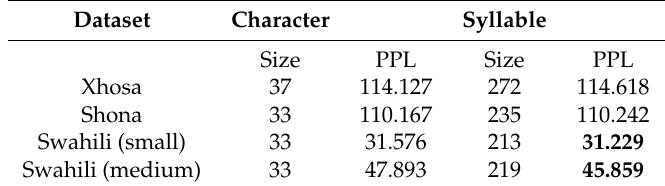
Table 6. The perplexity results (PPL) of the WEFSE model. The Syllable model completely outperforms the character counterpart on both small and medium datasets. The bolded values represent the best performance.